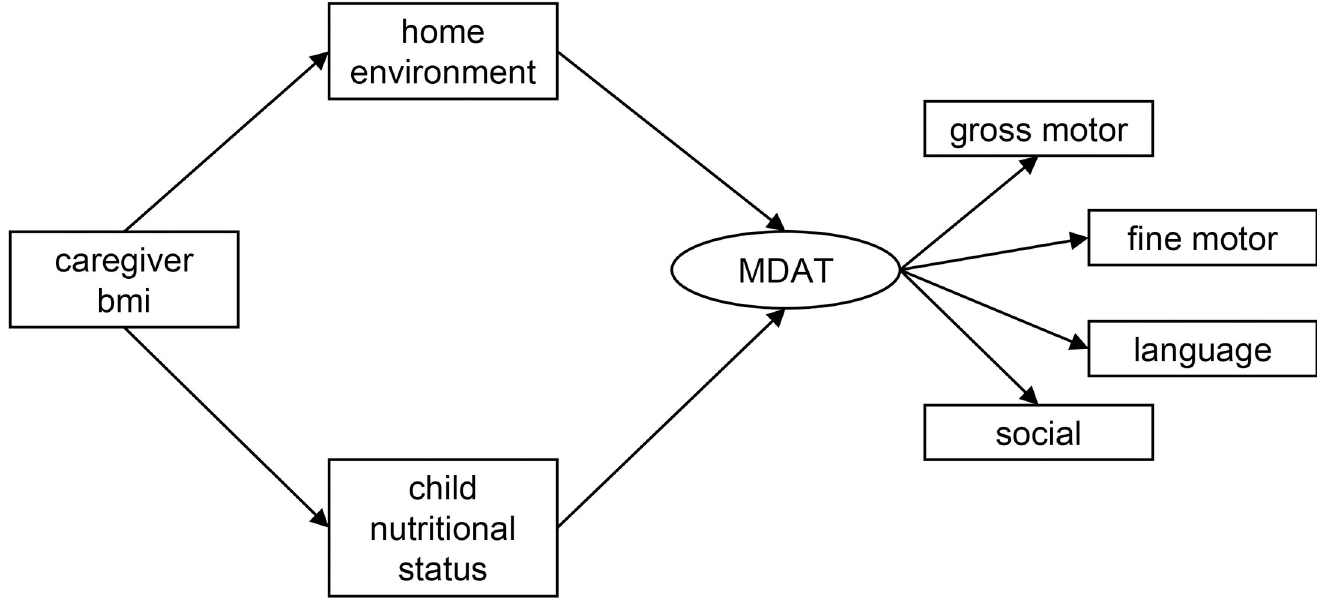
Fig 1. Hypothesized pathways between caregiver BMI, the home environment, child nutritional status and development in children with SAM. Caregiver body mass index (bmi); home environment according to the Home Observation for Measurement of the Environment Inventory; child nutritional status according to weight-for-height z-scores (whz), weight-for-age z-scores (waz), height-for-age z-scores (haz), or mid-upper arm circumference (muac); and development according to MDAT (Malawi Developmental Assessment Tool) z-scores.